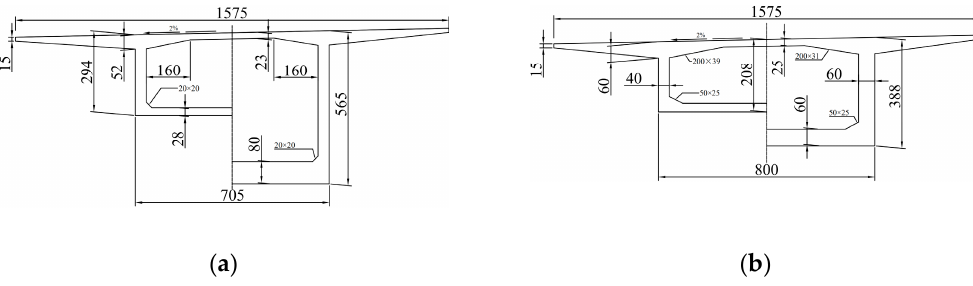
Figure 6. Design cross-section layout (unit: cm). ( a ) Bridge A, ( b ) Bridge B.